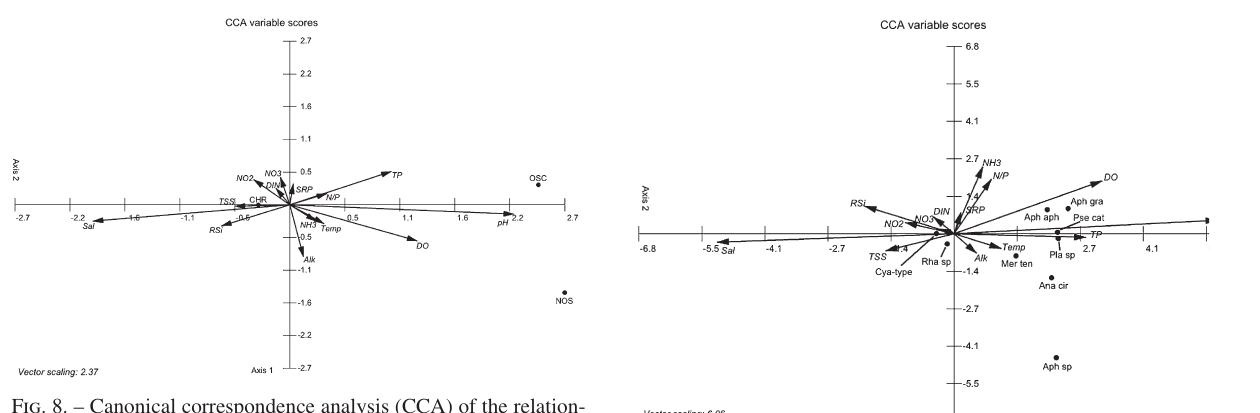
Fig . 8. – Canonical correspondence analysis (CCA) of the relation- ship orders–environment. (DO, Dissolved Oxigen; Temp, Tempera- ture; Sal, Salinity; Alk, Alkalinity; TSS, Total Solids in Suspen- Fig . 9. – Canonical correspondence analysis (CCA) of the relation- sion; NO3, Nitrate; NO2, Nitrite; NH3, Ammonia; DIN, Dissolved ship species–environment. (DO, Dissolved Oxygen; Temp, Tem- Inorganic Nitrogen; RSi, Reactive Silica; TP, Total Phosphorus; perature; Sal, Salinity; Alk, Alkalinity; TSS, Total Solids in Suspen- SRP,orthophosphates; N/P, DIN/SRP. For abbreviations of orders, sion; NO3, Nitrate; NO2, Nitrite; NH3, Ammonia; DIN, Dissolved see Fig. 6). Inorganic Nitrogen; RSi, Reactive Silica; TP, Total Phosphorus; SRP, orthophosphates; N/P, DIN/SRP. For species abbreviations, see Table